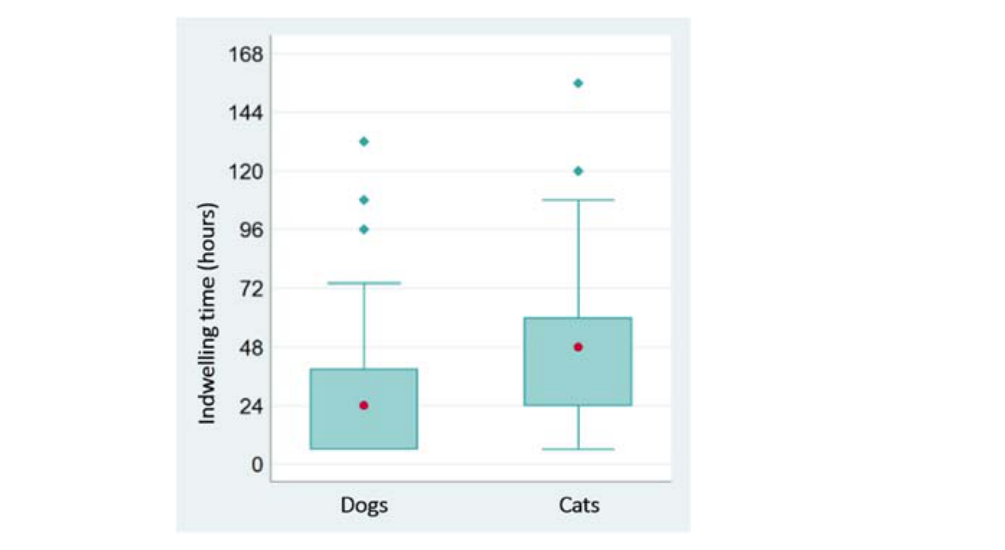
Figure 1. Boxplot of indwelling times of catheters in dogs and cats (red circles indicate the median values of the distribution).